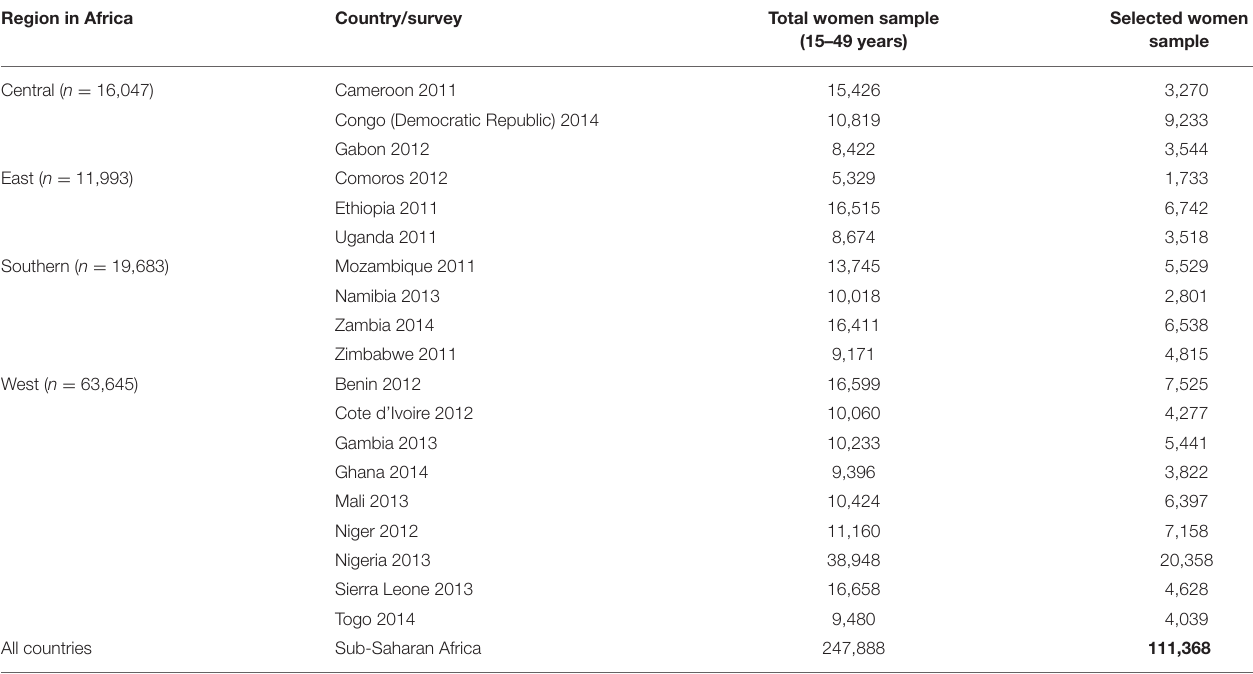
Selected women sample